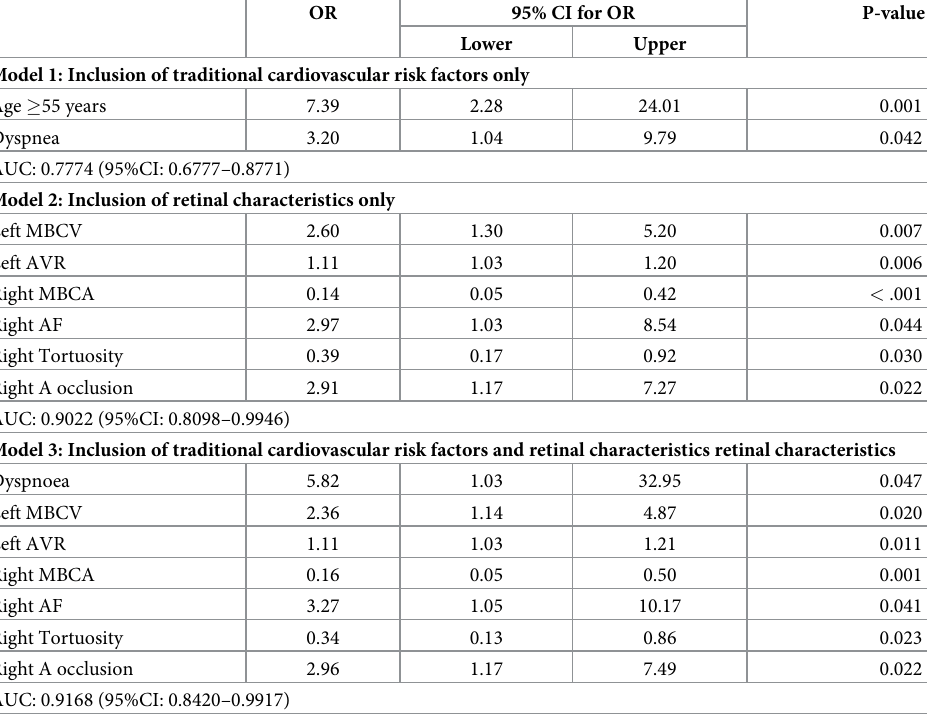
Table 4. Stepwise logistic regression analysis showing factors associated with obstructive coronary artery disease in different models. OR 95% CI for OR P-value Lower Upper Model 1: Inclusion of traditional cardiovascular risk factors only Age � 55 years 7.39 AUC: 0.7774 (95%CI: 0.6777–0.8771) Model 2: Inclusion of retinal characteristics only Left MBCV Left AVR Right MBCA Right AF Right Tortuosity Right A occlusion AUC: 0.9022 (95%CI: 0.8098–0.9946) Model 3: Inclusion of traditional cardiovascular risk factors and retinal characteristics retinal characteristics Dyspnoea 5.82 1.03 32.95 0.047 Left MBCV 2.36 Left AVR Right MBCA 0.16 Right AF Right Tortuosity 0.34 Right A occlusion 2.96 AUC: 0.9168 (95%CI: 0.8420–0.9917) Abbreviations: MBCA, bifurcation coefficient of artery; MBCV, bifurcation coefficient of venule; AF, atrial fibrillation; Tortuosity, Tortuosity; A occlusion, Arteriole occlusion; AVR, Arteriole-venule